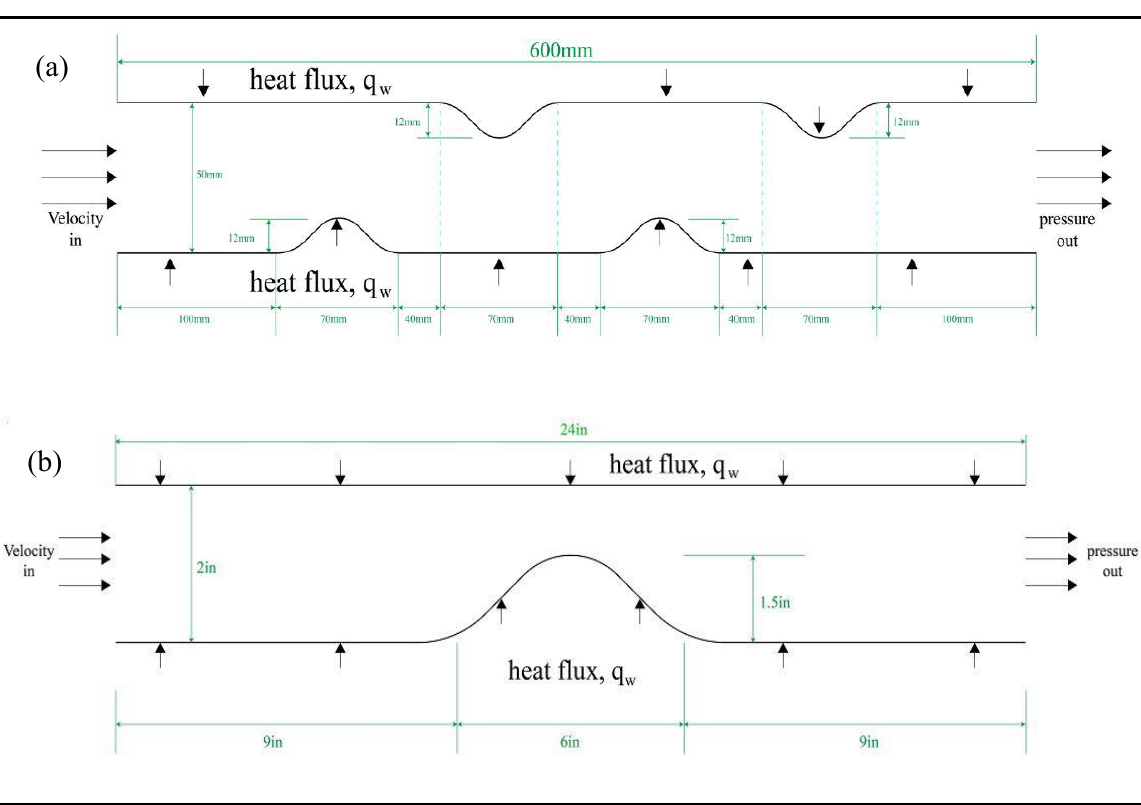
Fig. 1. Computational Model (a) Single Restriction (b) Multiple